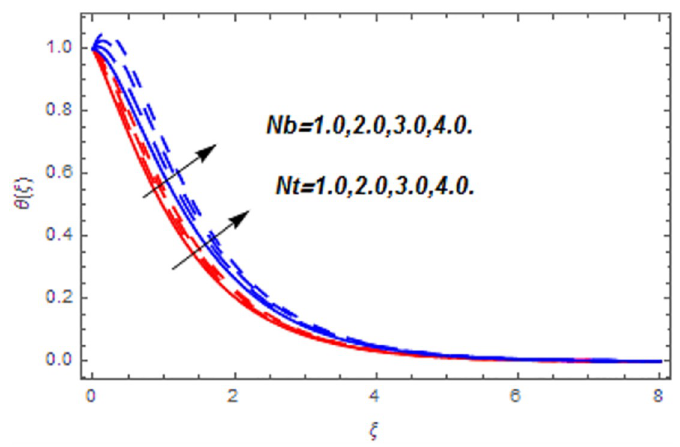
Fig 5. Thermal profiles versus Brownian motion and thermophoresis